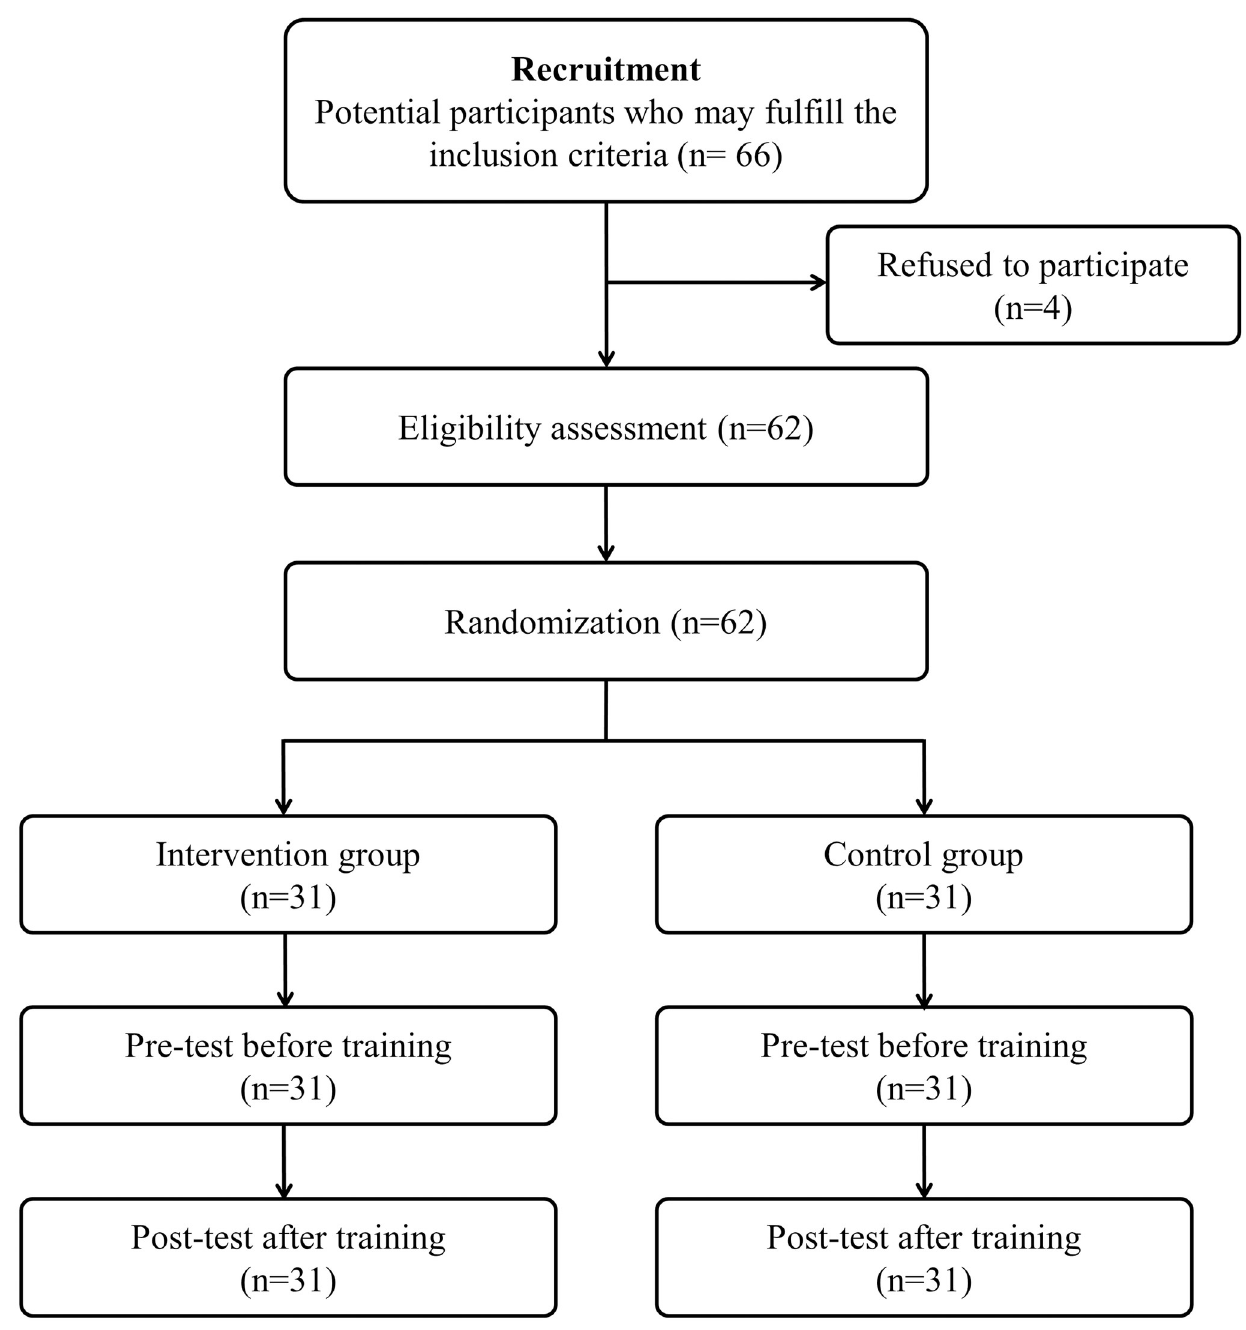
Fig 3. Flowchart for the cardiopulmonary resuscitation training and skill assessment.